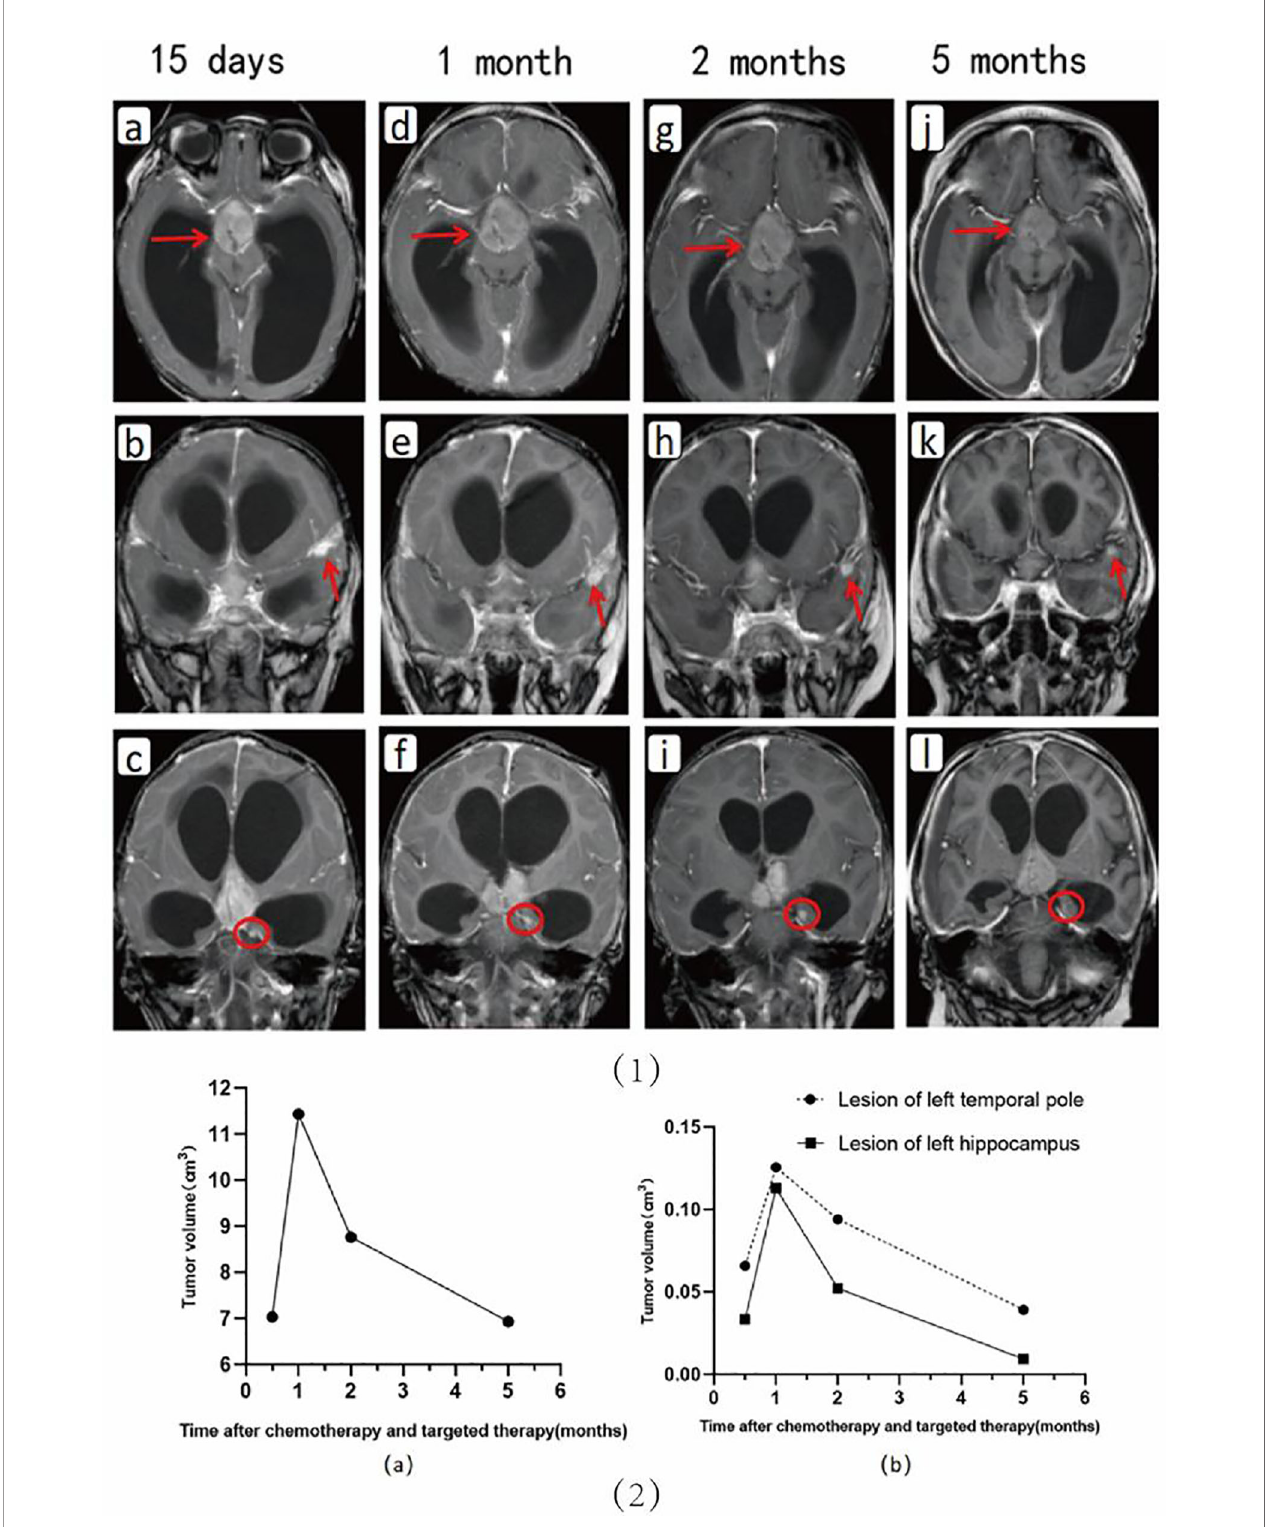
FIGURE 2 | Upper: Changes in the cerebral lesions are seen on imaging during chemotherapy and anti-ALK therapy. Shown are images at 15 days (A – C) , 1 month (D – F) , 2 months (G – I), and 5 months (J – L) after the start of drug therapy, respectively. Lower: Shown are the volumetric changes in the supra-sellar lesion (A) and in the lesions in the left temporal pole and hippocampus (B) during chemotherapy and targeted